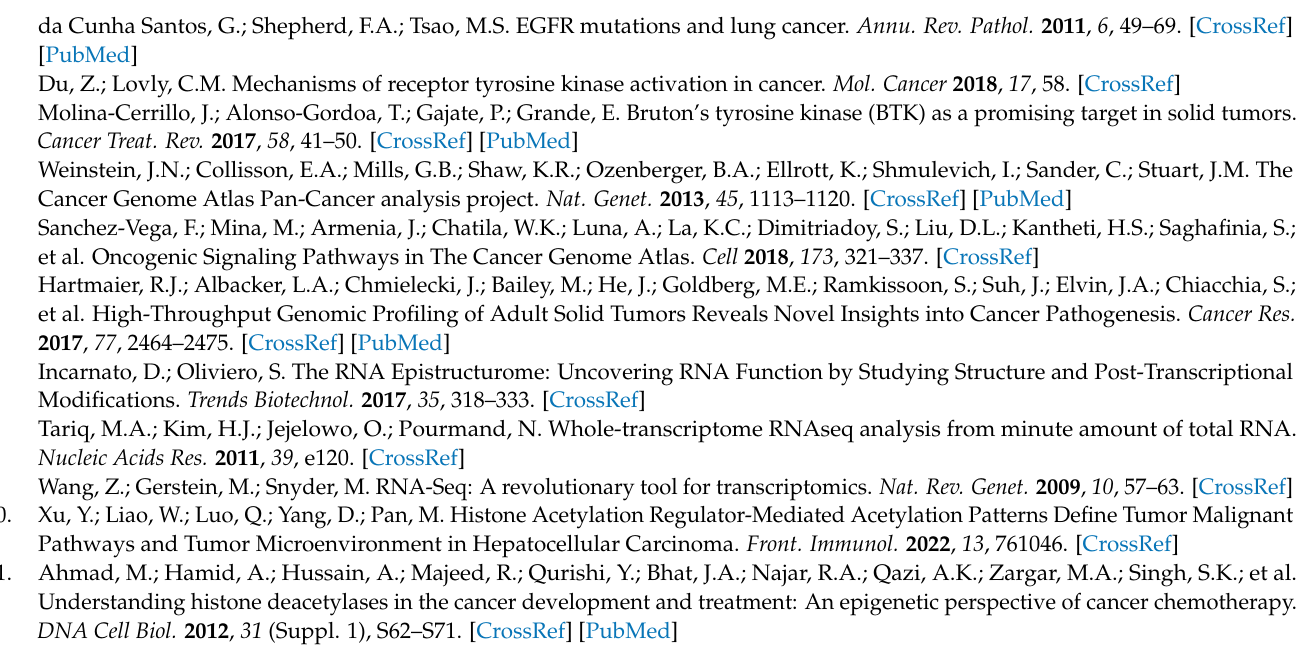
KAT2A and E2F1 ; Figure S2. GO and KEGG enrichments of KAT2A and E2F1 target genes; Figure S3. KAT2A and E2F1 regulate the transcription of UBE2C through E2F1 binding site; Figure S4. The expression level of UBE2C in different cell types in cancer tissues; Figure S5. Interference with UBE2C significantly inhibits cancer cell proliferation; Figure S6. Interference with UBE2C significantly inhibited cancer cell migration; Figure S7. Interfering UBE2C could remarkably repress cancer cell invasion; Figure S8. Interference with UBE2C significantly promoted cancer cell apoptosis; Figure S9. Interference with UBE2C significantly induced cell cycle arrest; Figure S10. Top 15 of GO terms, top 12 of KEGG signaling pathways and PPI network of 596 DEGs that are regulated by UBE2C ; Table S1. Summary of cancer and normal samples analyzed in this study; Table S2. Primers and interfering sequence for target genes used in this study; Table S3. A total of 222 DEGs regulated by KAT2A and E2F1 appeared in more than five cancer types among 11 different types of cancer at the same